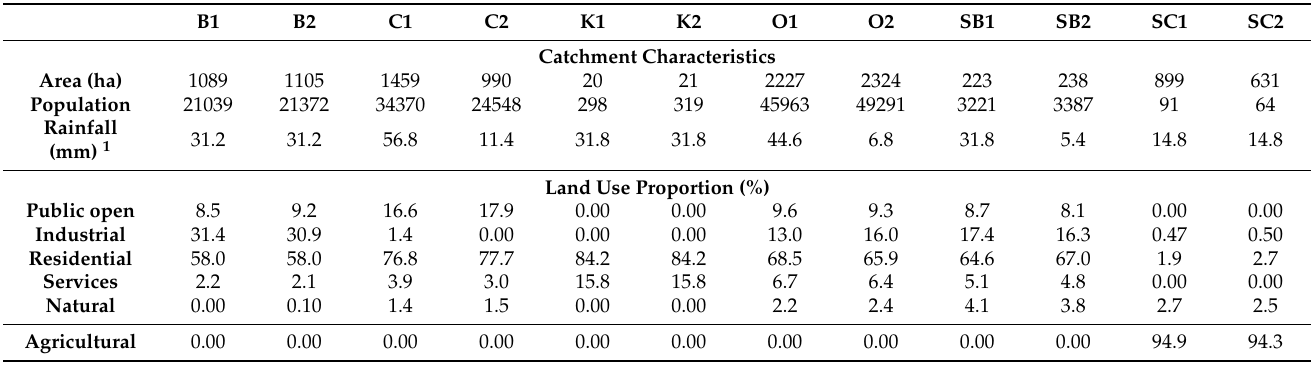
Table 2. Summary of drain and catchment characteristics derived from catchment